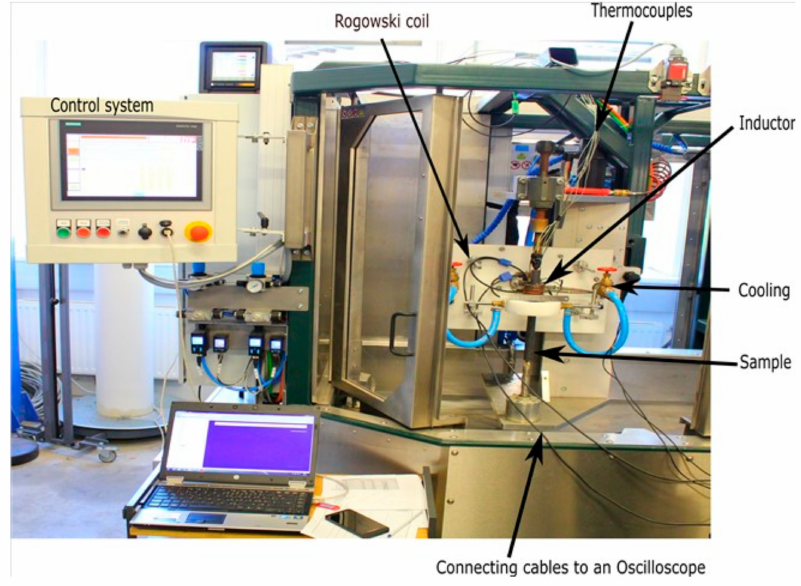
Figure 3. The induction heating test rig setup (product model: HU-VH300-MS30, manufacturer: Ideal Thermal Processes GmbH (ITP), city: Oberkirch, country: